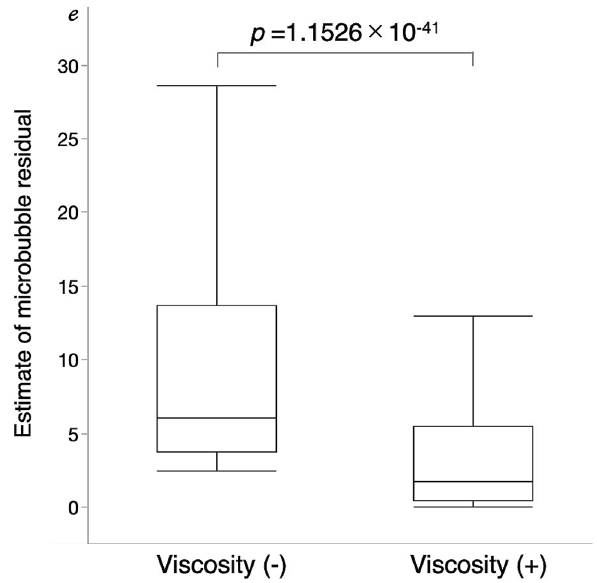
Figure 6. Dependency of the estimation accuracy on the blood viscosity factor. Left box plot presents the estimation residuals obtained from the model without the viscosity factor. Right box plot presents the estimation residuals of the proposed model that included the viscosity factor as one of the contributory factors. RMSE between the measured and estimated numbers of the microbubbles.